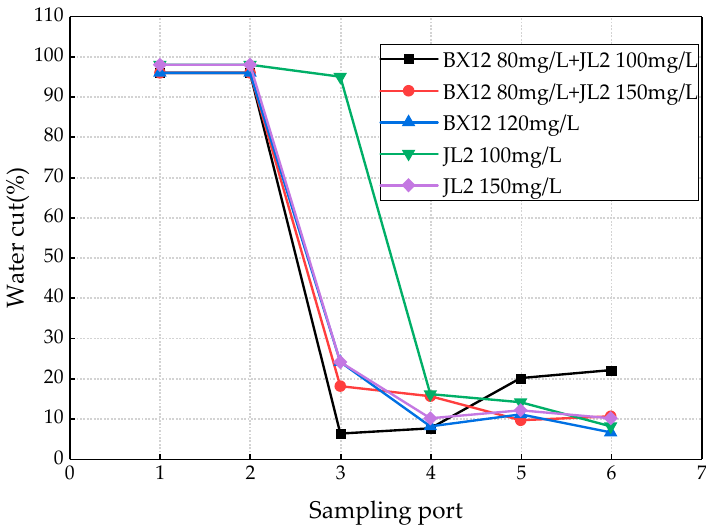
Figure 11. Water cut of each sampling ports under different chemicals and addition.